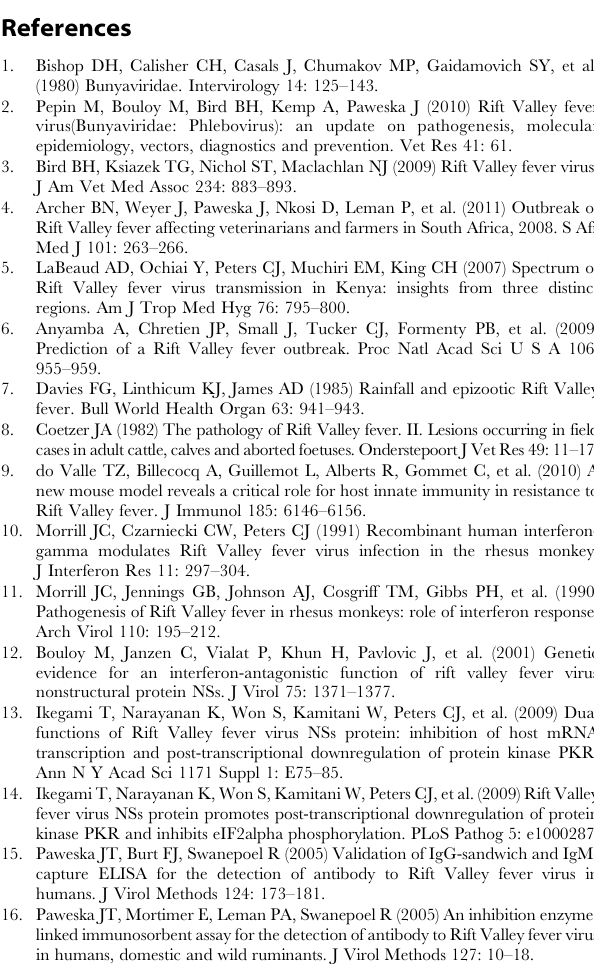
Figure S1 Phenotype of goat monocyte-derived dendrit- ic cells. MoDCs were differentiated from adherent blood monocytes using recombinant bovine GM-CSF and IL-4. For controls, adherent monocytes were cultured in culture medium only (M W ). Pictures were taken on days 0, 3 and 6. On day 7, MoDCs and M W were harvested and analyzed by flow